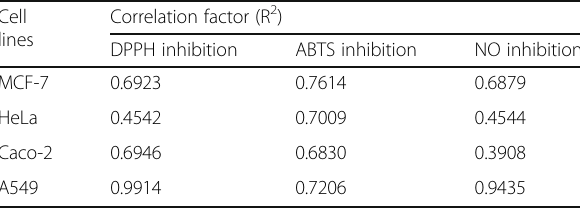
Table 4 Correlation between radical inhibition potency of extracts from roots, fruits, bark and leaves of Sarcocephalus pobeguinii with respect to their antiproliferative activity